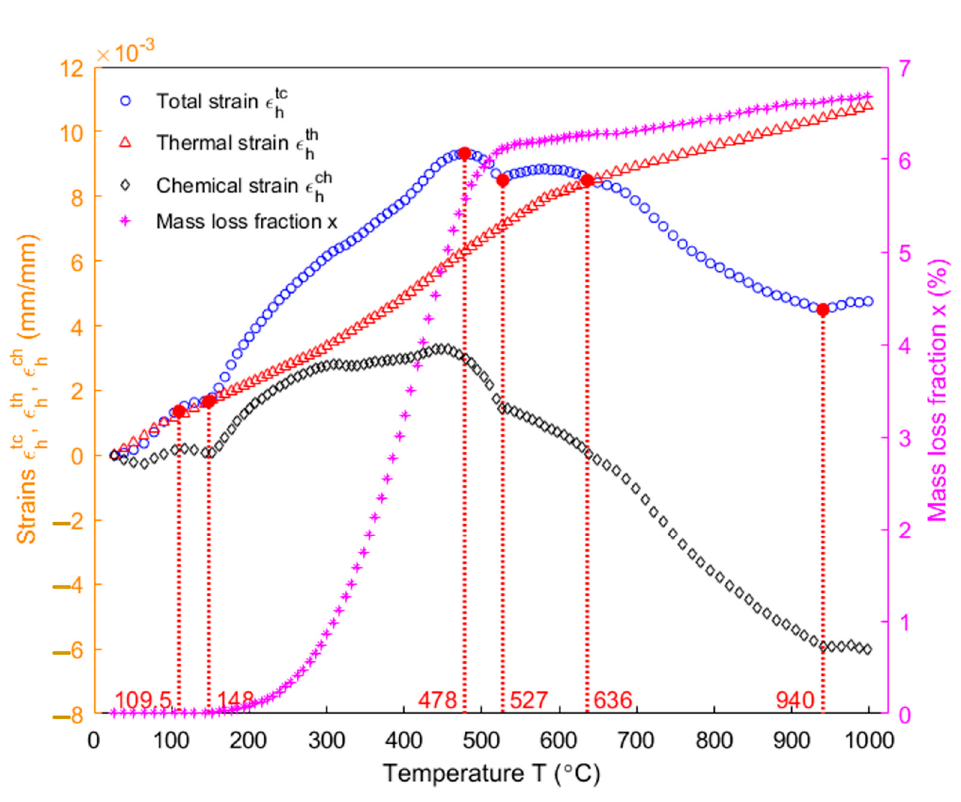
Figure 15. Evolution of the total strain, the thermal strain, the chemical strain of the sample in the axial direction and the mass loss fraction as a function of temperature.